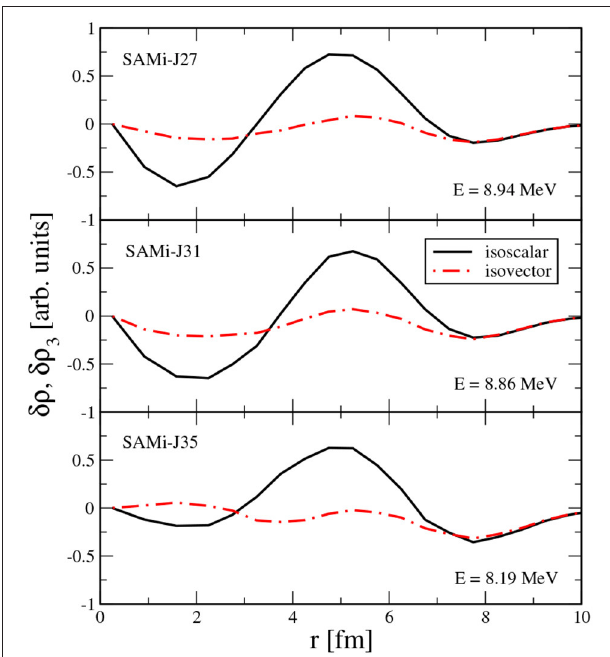
FIGURE 7 | (Color online) Radial dependence of the isoscalar and isovector transition density for the lowest energy dipole mode, for 132 Sn and three SAMi-J interactions. Readapted from Zheng et al.